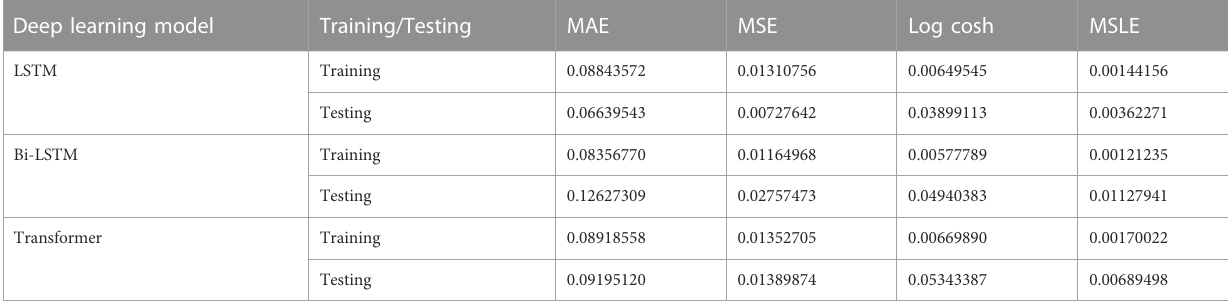
TABLE 2 Results of different models during training and testing using Indonesia Dataset. Deep learning